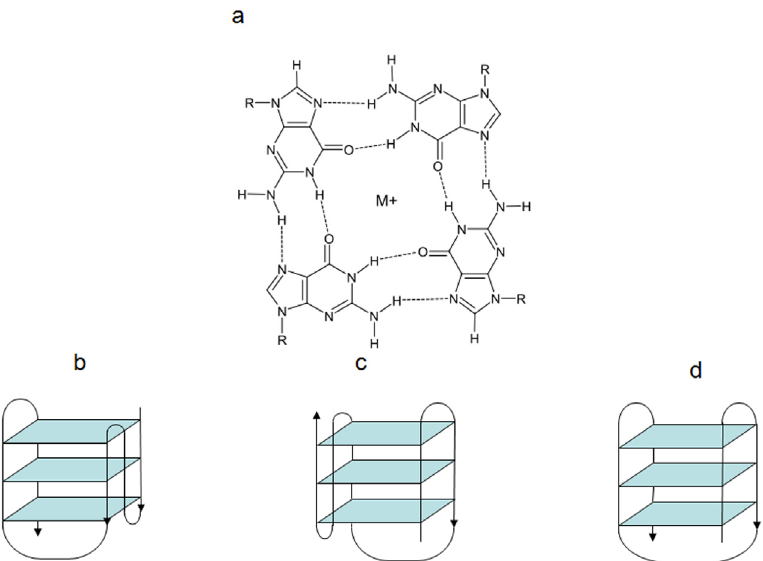
Figure 1. Schematic representation of a G-quartet arrengment ( a ) and of G4 structures with an intramolecular hybrid-type 1 ( b ), hybrid-type 2 ( c ) and basket-type ( d ) conformation. M + : alkali